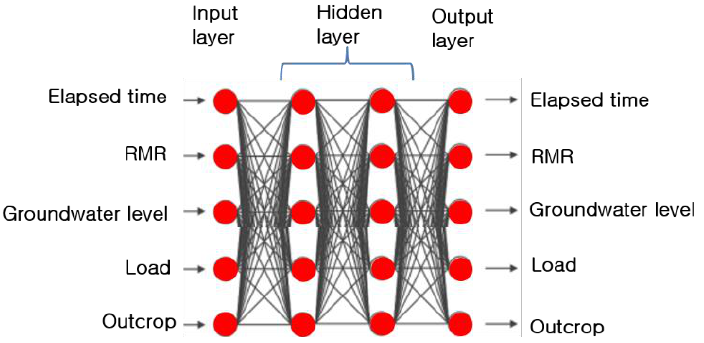
Figure 12. ANN structure for the analysis of indirect influence factors.